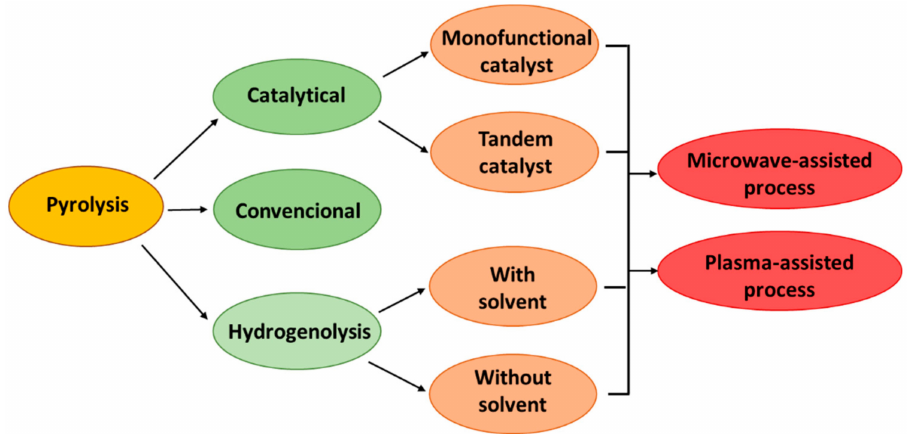
Figure 3. Pyrolytic methods of plastic